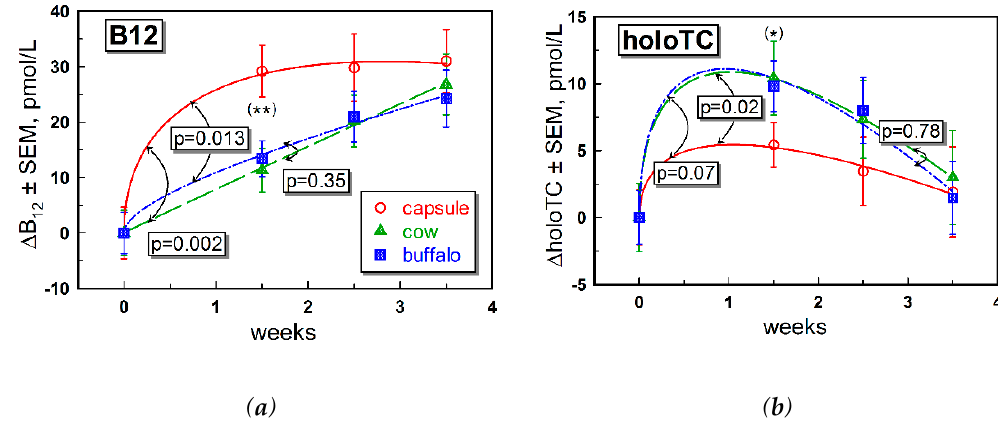
Figure 2. Time-dependent changes of the B12 ( a ) and holoTC ( b ) in the course of the three supplementation methods notated as “capsule”, “cow”, and “buffalo”. Both ( a ) and ( b ) present the data as mean values ± SEM for the supplementation with CN-B12 capsules ( ○ , red); cow milk ( ▲ , green); and buffalo milk ( ■ , blue). The solid lines of respective colors show the best approximations by Equation (2). Double arrows ( ↕ black) indicate the probability of identical fitting parameters in pairs cow = buffalo, capsule = cow and capsule = buffalo. The significance levels of p < 0.05/3, 0.05/2 and 0.05/1 for three comparisons were accepted for the lowest to the highest p -values observed (Holm-Bonferroni correction, see methods section 2.7). Symbols (*) and (**) indicate differences (ANOVA, p < 0.05 and 0.01, respectively) between the datasets at the particular time points. HoloTC: